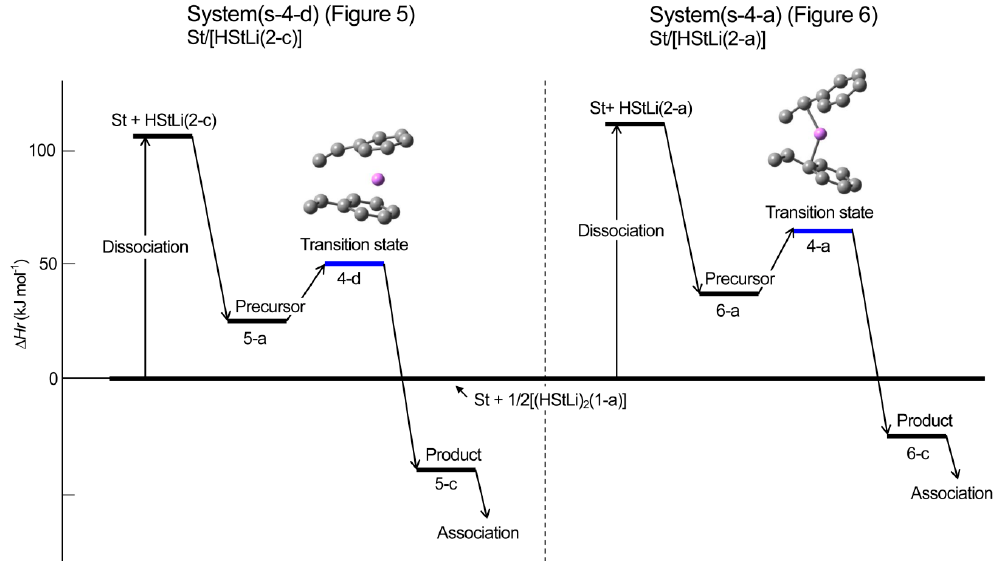
Figure 7. Enthalpy changes for the addition of styrene to HStLi in the gas phase.